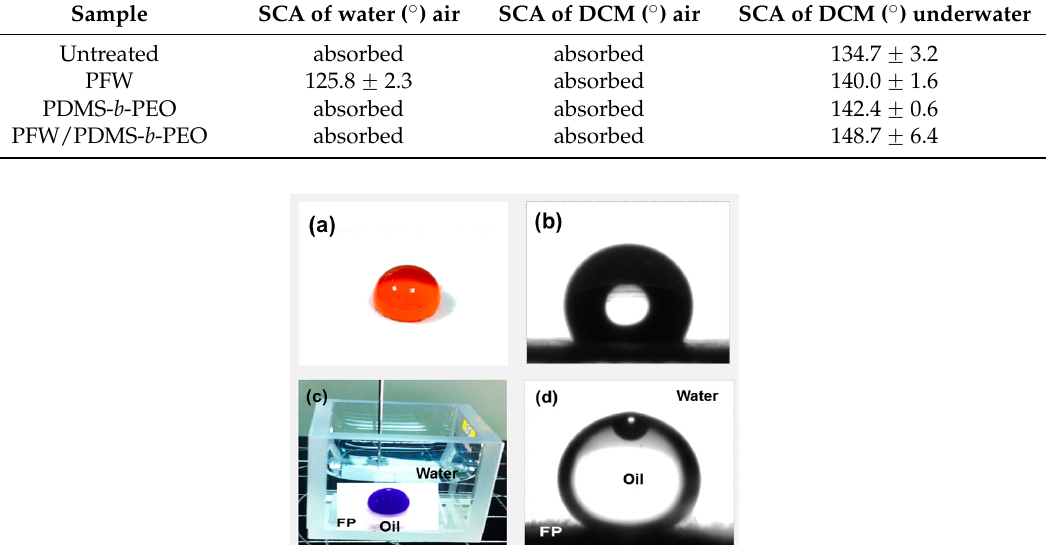
Figure 6. ( a ) Water droplet on PFW-treated FP. Methyl orange dye (0.01 wt %) is used to color the water, ( b ) water contact angle (125.8° ± 2.3°) of PFW-treated FP, ( c ) underwater DCM droplet on PFW/PDMS- b -PEO-treated FPs. Sudan blue dye (0.01%) is used to color the DCM, and ( d ) underwater DCM contact angle (148.7° ± 6.4°) of PFW/PDMS- b -PEO-treated FPs.